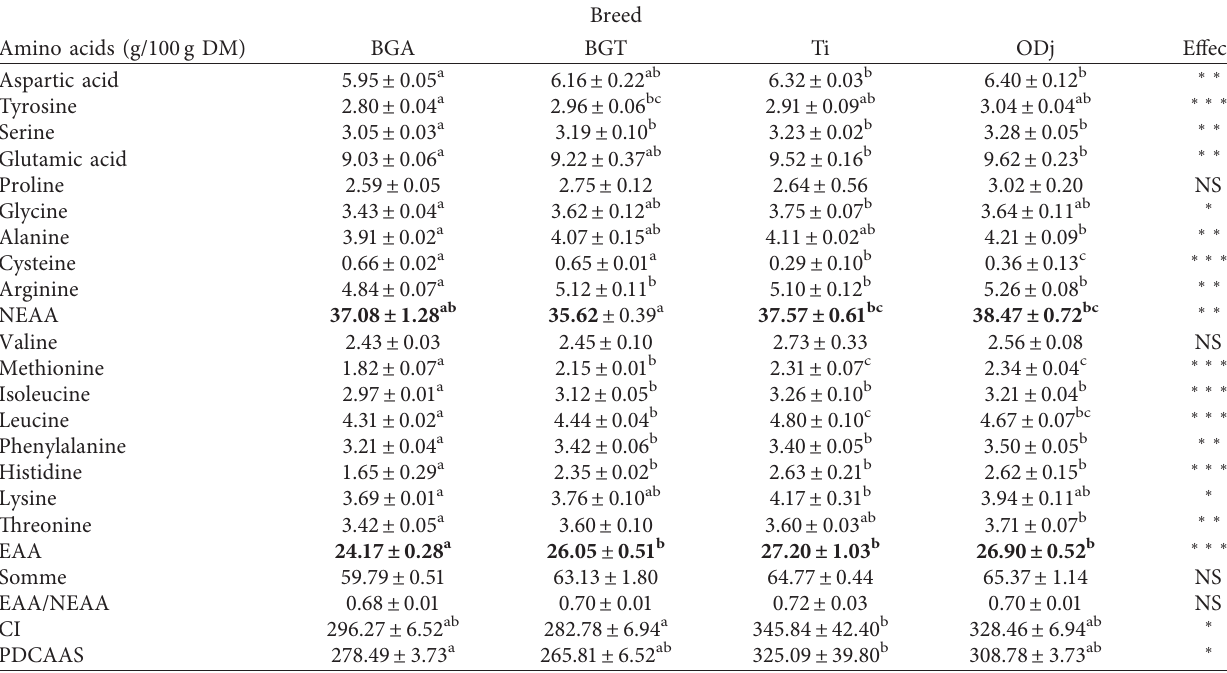
Table 4: Amino acids composition of Beni-Guil, Timahdite, and Ouled-Djellal sheep meats.